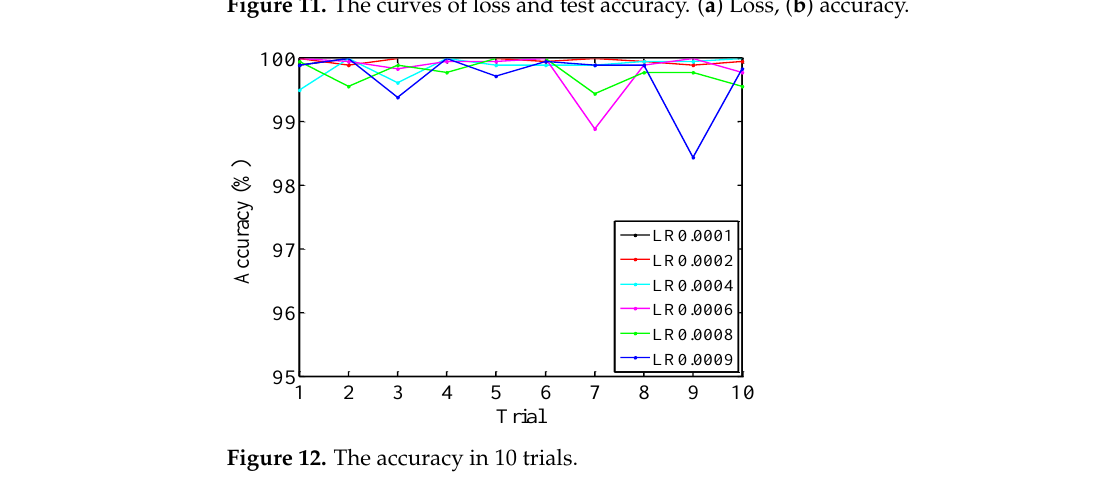
Figure 12. The accuracy in 10 trials.